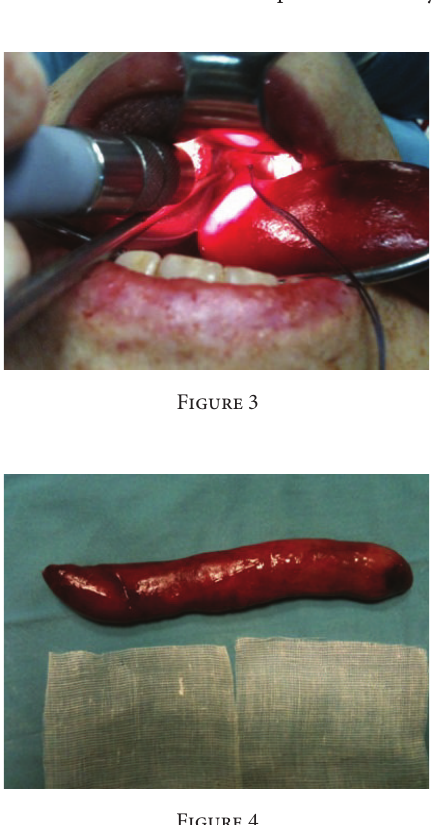
residual disease and the advanced state of reepithelialization of the implant